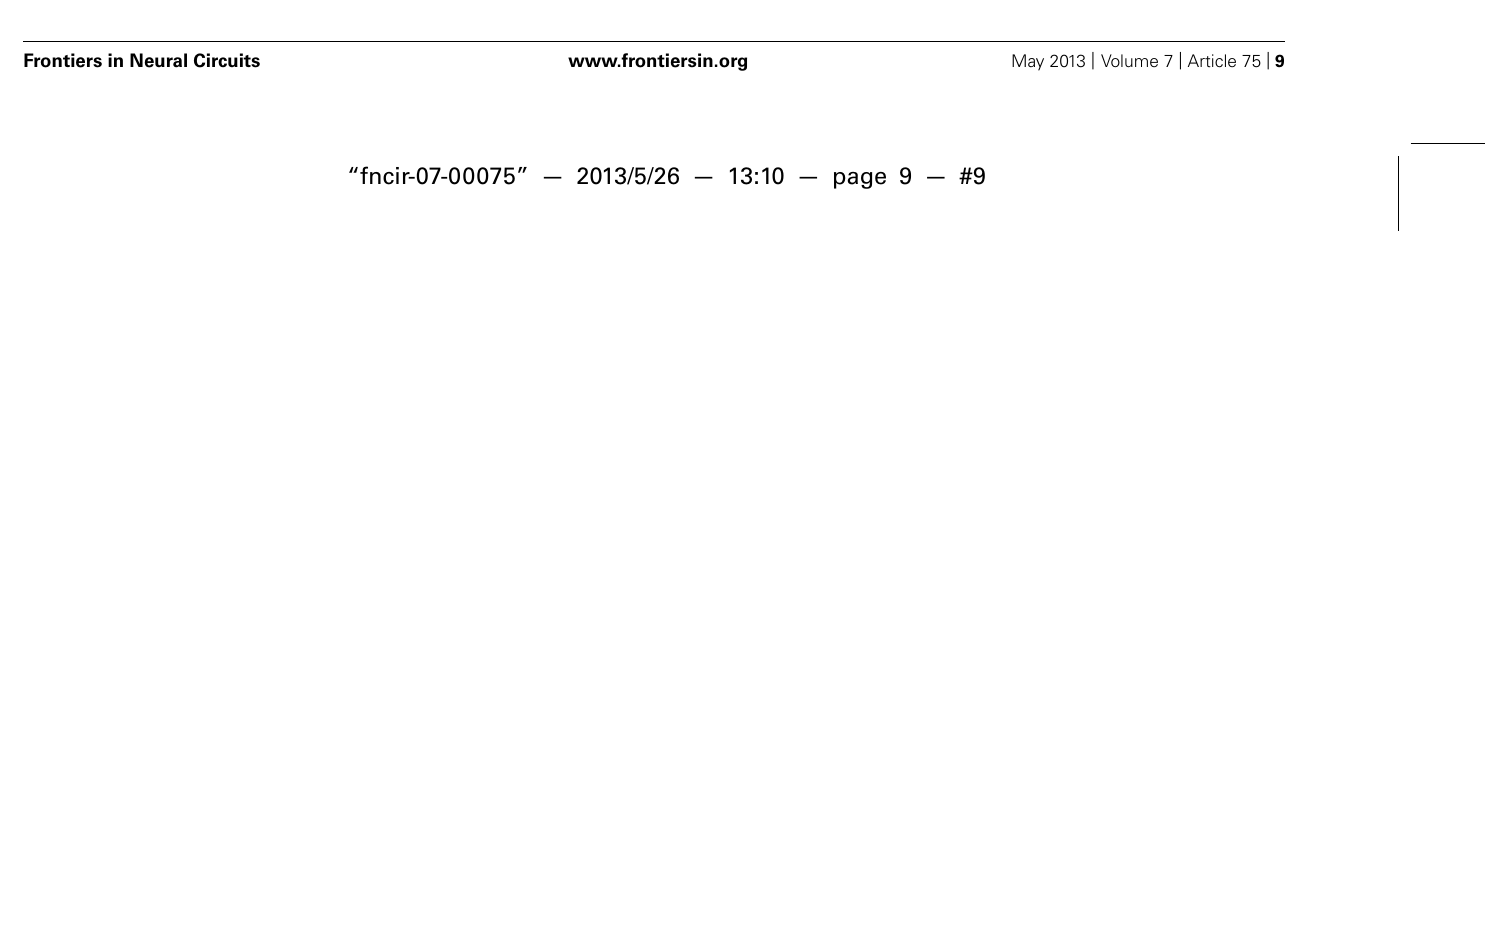
thickness of a curved arrow indicates the relative intensity of the projection. (B) A conceivable cortical circuit for motor control, which is composed of thalamic afferents and local connections to CSNs. Modified with permission from Figure 9 of Cho etal. (2004b) and Figure 9 of Kuramoto etal.